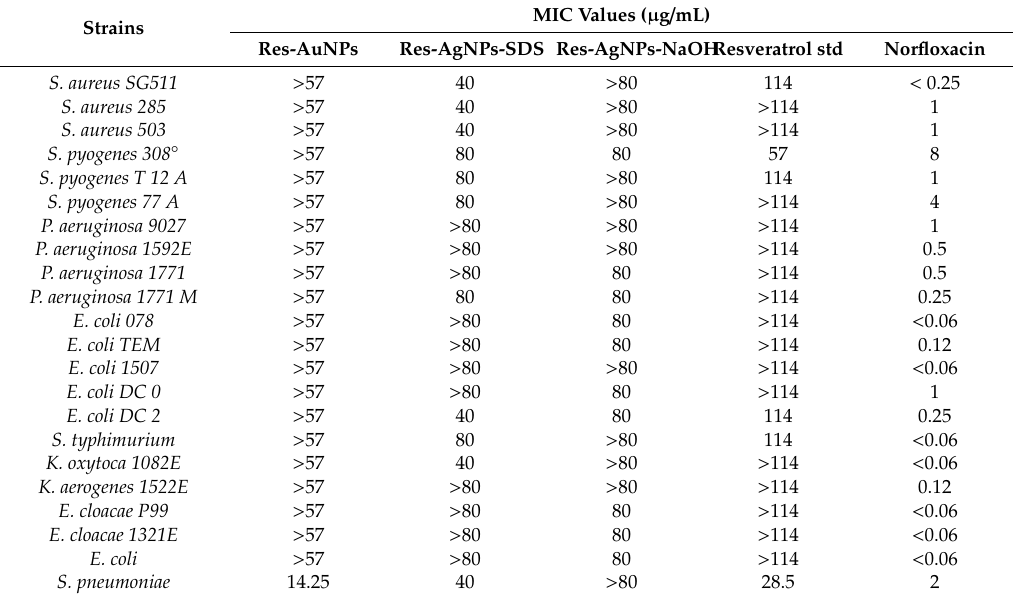
Table 19. MIC values of Res-AuNPs, Res-AgNPs-SDS, Res-AgNPs-NaOH, resveratrol standard, and norfloxacin, used as standard antibiotic from Park et al. (2016) [132]. MIC Values ( µ g / Strains